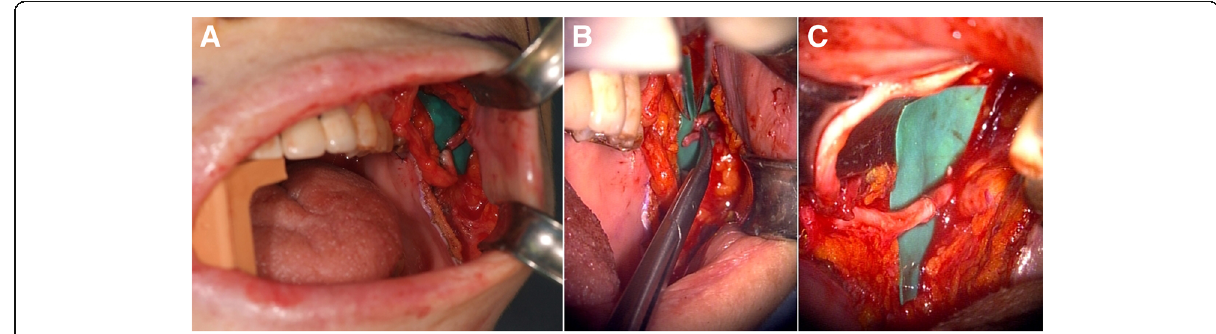
Fig. 4 Clinical photographs showing the anastomosis of the sural nerve with the buccal branches of the facial nerve under a microscope. a Positioning of the harvested sural nerve with its distal end facing the non-paralyzed buccal branch. b Preparation of the buccal branch. c Placement of epineural sutures between the sural and buccal branch of the facial nerve in the non-paralyzed